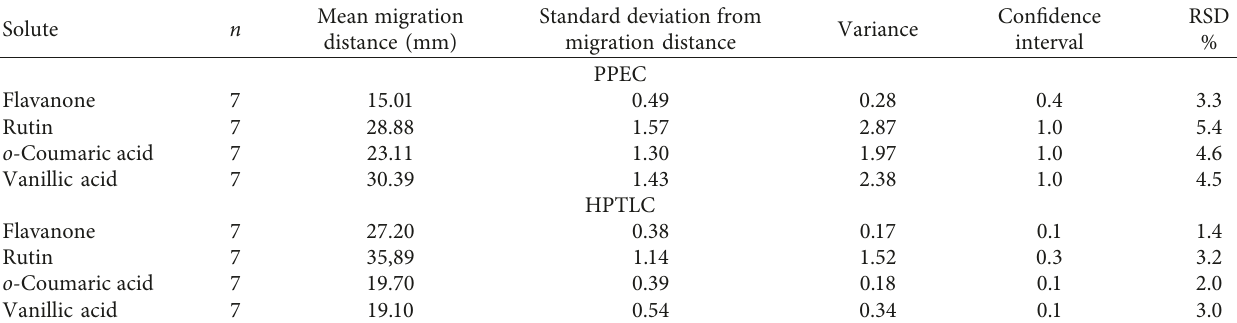
Table 2: Statistic evaluation of chosen flavonoid and phenolic acid migration distances in PPEC and TLC techniques. Mean migration Standard deviation from Solute n distance (mm) migration distance